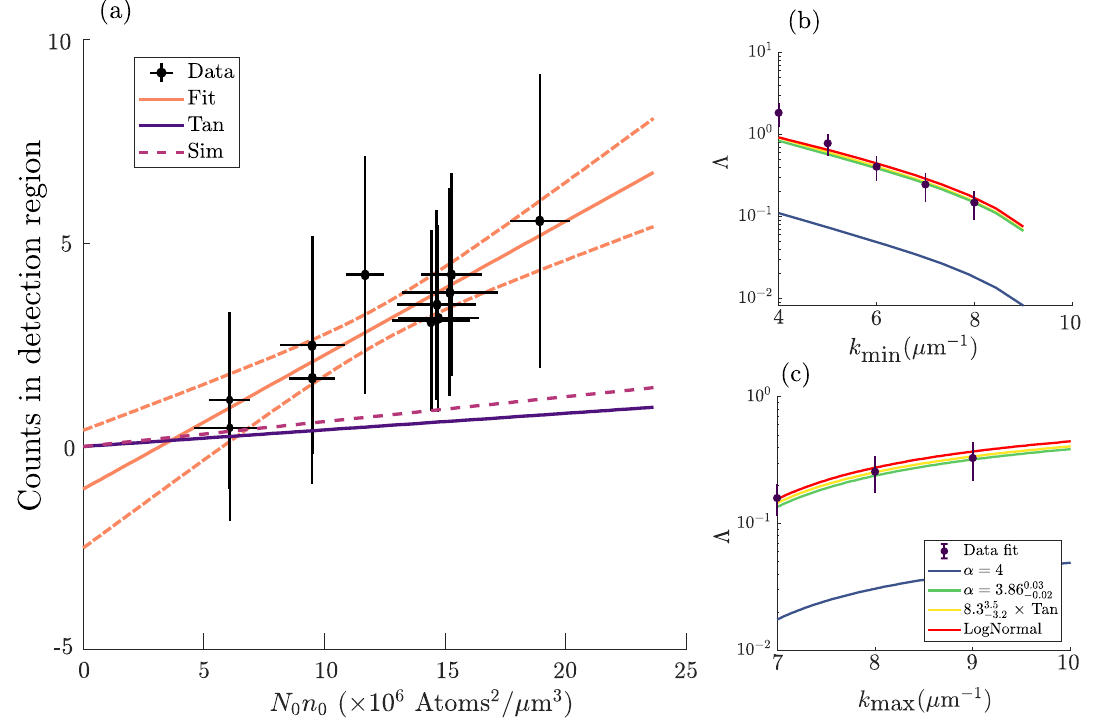
Figure 2. Population of momentum tails, including excess compared to Tan–Bogoliubov theory. ( a ) The product N 0 n 0 is a linear predictor of the number of counts within the region ( k min 6 µ m − 1 , k max 10 µ m − 1 ) , consistent with Eq. (10) (solid orange line, dashed lines 95% CI). The = = gradient (cid:31) in Eq. (15) can be predicted using Eq. (10) ( (cid:31) pred solid purple line) but this disagrees with the experiment by a factor of about 8. Our simulations (dashed line, CE in Fig. 3a) show an increase in counts after release but by less than in the experiment. In ( b,c ) linear fits to the experimental data yield (cid:31) fit (points) which 10 µ m − 1 in ( b ) and k min 6 µ m − 1 in ( c )). For comparison, we vary with the choice of k bounds (fixing k max = = C / k 4 ), along with the predictions from show predictions of (cid:31) based directly on Eq. (10) ( (cid:31) pred , blue, n ( k ) = AC / k 4 that has an additional prefactor A 8 ( 3 ) (green) and one Eq. (15) using a density function n ( k ) = = C / k α (yellow). A log-normal distribution produces 3.86 ( 2 ) via n ( k ) that has a modified exponent of α = = nearly identical predictions (red, offset vertically for visibility). Quoted error estimates correspond to 95% CI of the fit parameters. In ( b ), the deviation from the predictions at k min (cid:31) 6 µ m − 1 is because the collection area starts to overlap with the thermal